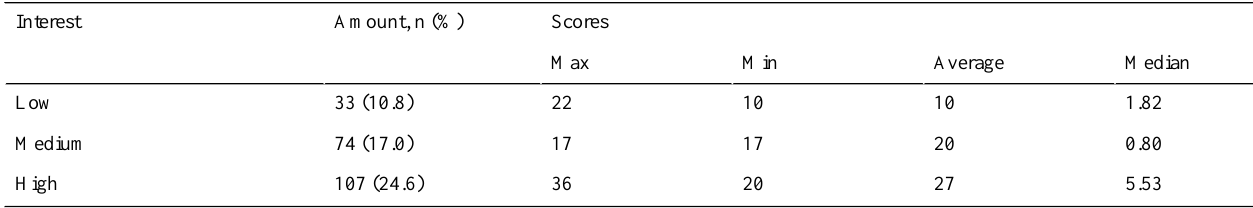
Table 2. App interest statistics (n=433).